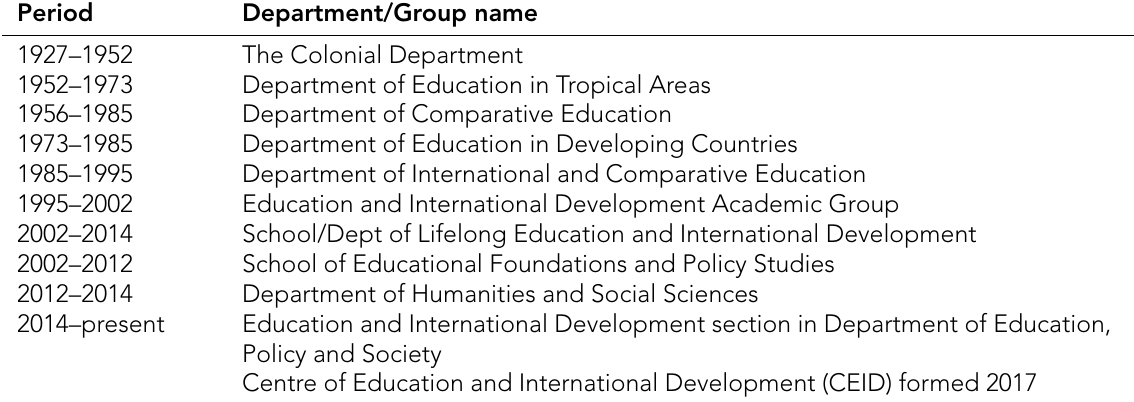
Table 1. Education and international development work at IOE: changing formulations (Source: data compiled from Aldrich and Woodin, 2021; Little, 2004; interviews with Angela Little, Carew Treffgarne, Peter Williams, Chris Yates, Pat Pridmore and Moses Oketch. EFPS School